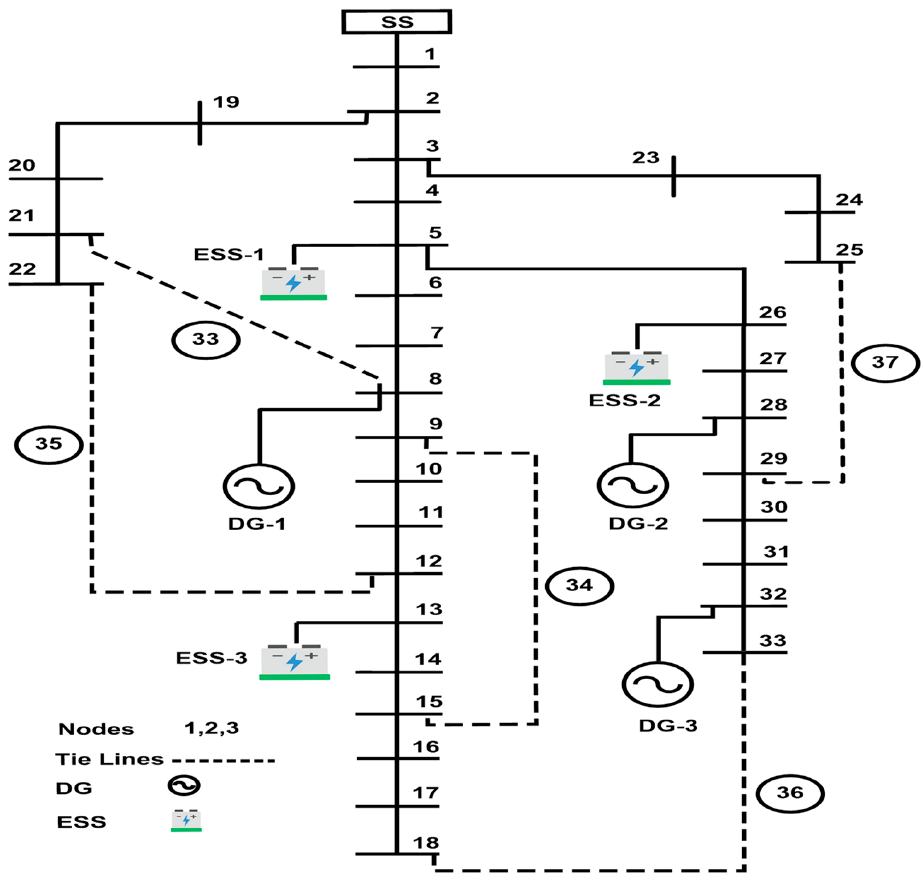
Figure 3. A sample 33-node radial distribution system.